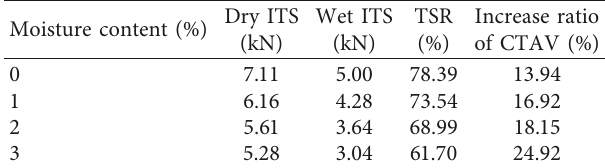
Table 13: ITS/TSR of the RH-WMA uncut samples with dried/ moist